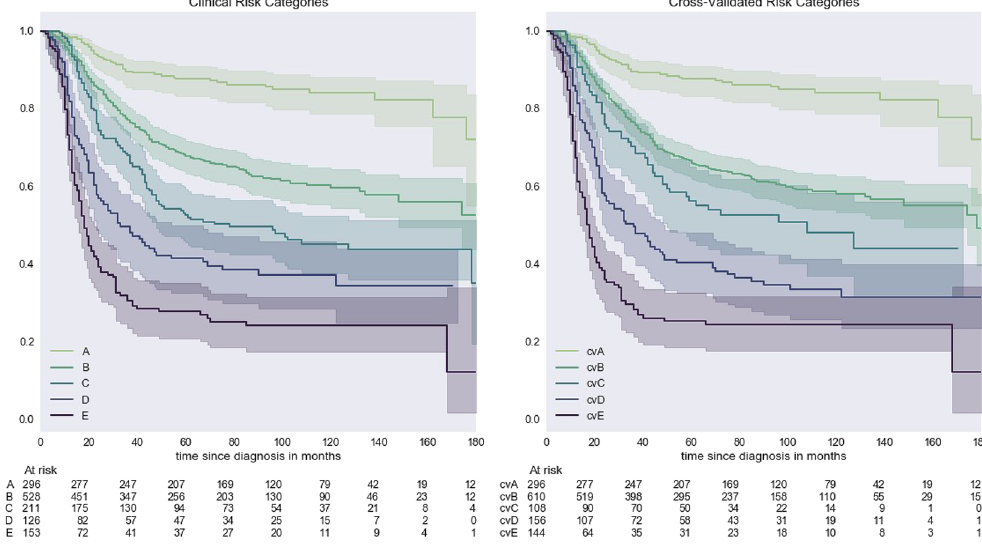
Figure 3. Kaplan-Meier curves for overall survival of clinical risk categories and cross-validated risk categories. Survival is measured in months from diagnosis. On the left the Kaplan-Meier survival curves of the clinical risk categories ( A–E ) based on the 13 prognostic groups. On the right the Kaplan-Meier survival curves of the cross- validated risk categories